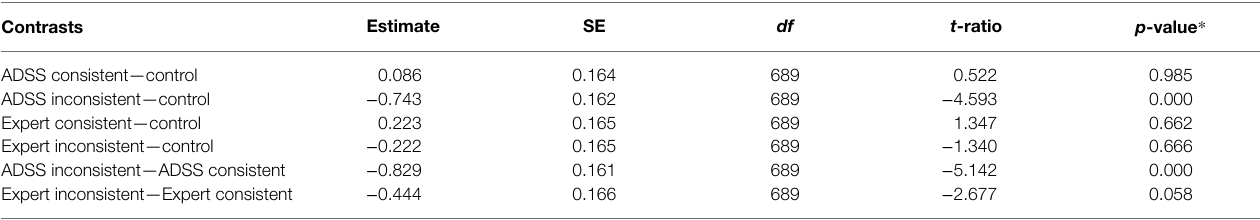
TABLE 3 | Contrast analysis (diff-scores depending on source and consistence of recommendations).